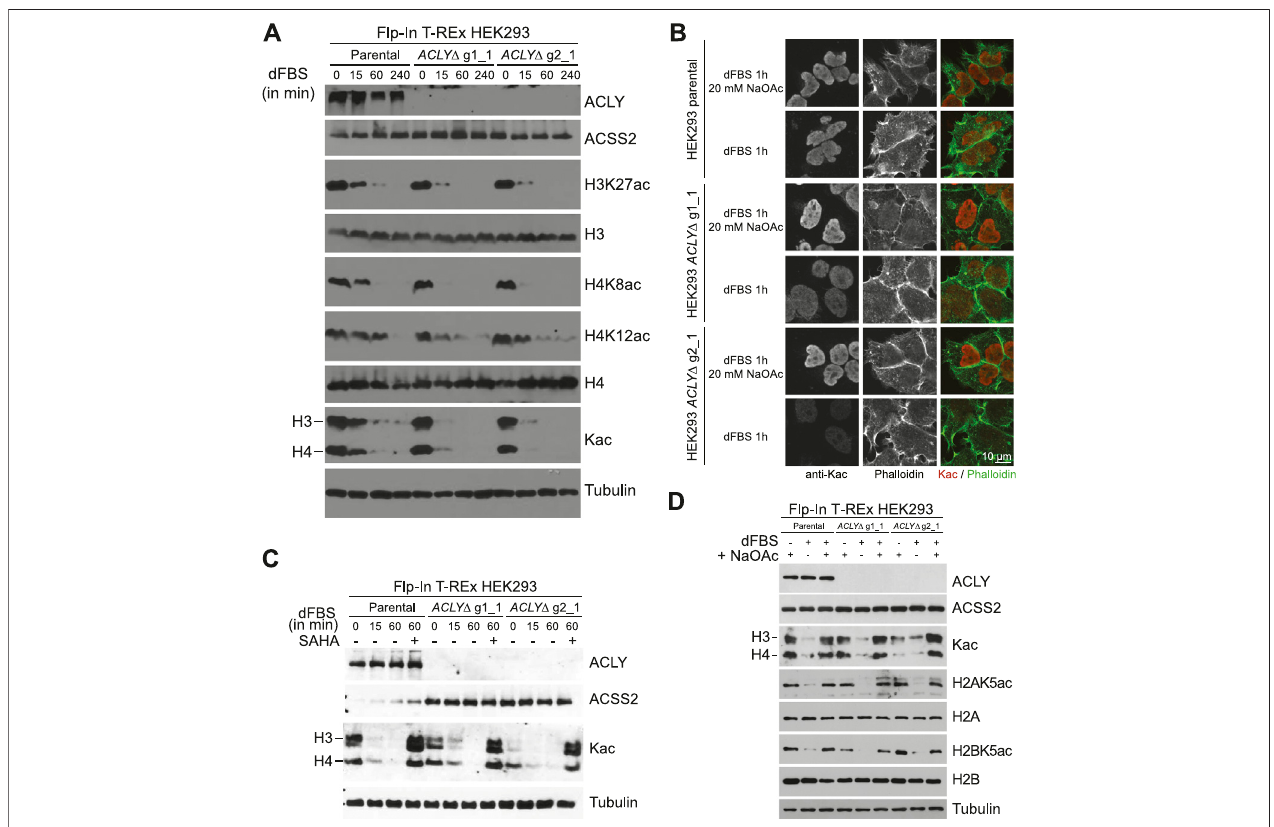
FIGURE 3 | Acetate depletion in HEK293 ACLY Δ cells decreases Kac levels rapidly. (A) Western blot analysis of ACLY, ACSS2, and histone Kac levels during a dFBS time-course of HEK293 ACLY Δ and parental cells. (B) Immuno fl uorescence of HEK293 ACLY Δ and parental cells incubated with and without NaOAc in medium containing 10% dFBS for 1 h. Cells were stained with anti-Kac antibodies and phalloidin. (C) Western blot analysis of ACLY, ACSS2, and histone Kac levels during a dFBS time-course of HEK293 ACLY Δ , and parental cells with or without 5 μ M suberanilohydroxamic acid (SAHA) treatment. (D) Western blot analysis of ACLY, ACSS2, and histone Kac levels following dFBS treatment of HEK293 ACLY Δ and parental cells with or without NaOAc supplementation.